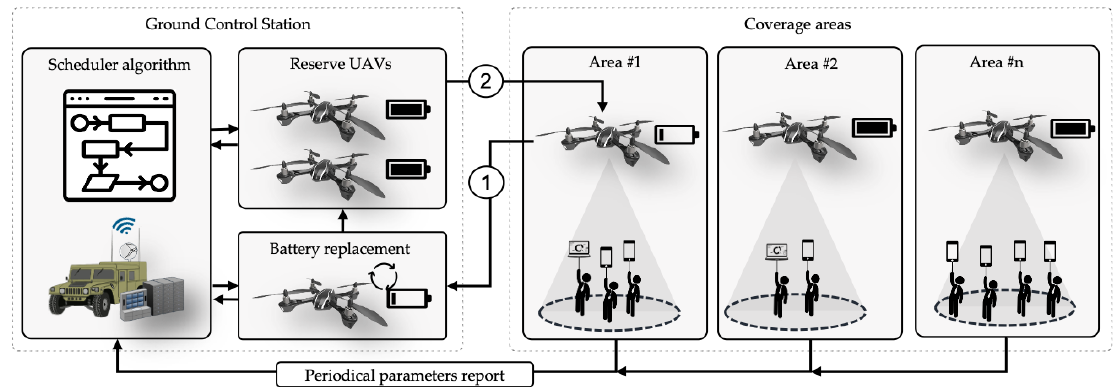
Figure 1. Typical Unmanned Aerial Vehicles (UAV) use case using the proposed